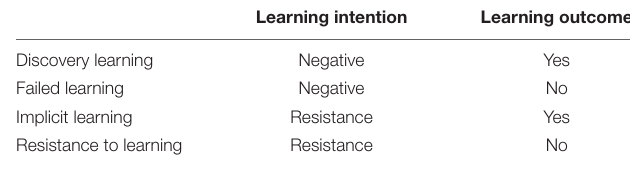
TABLE 3 | Task specifications of study